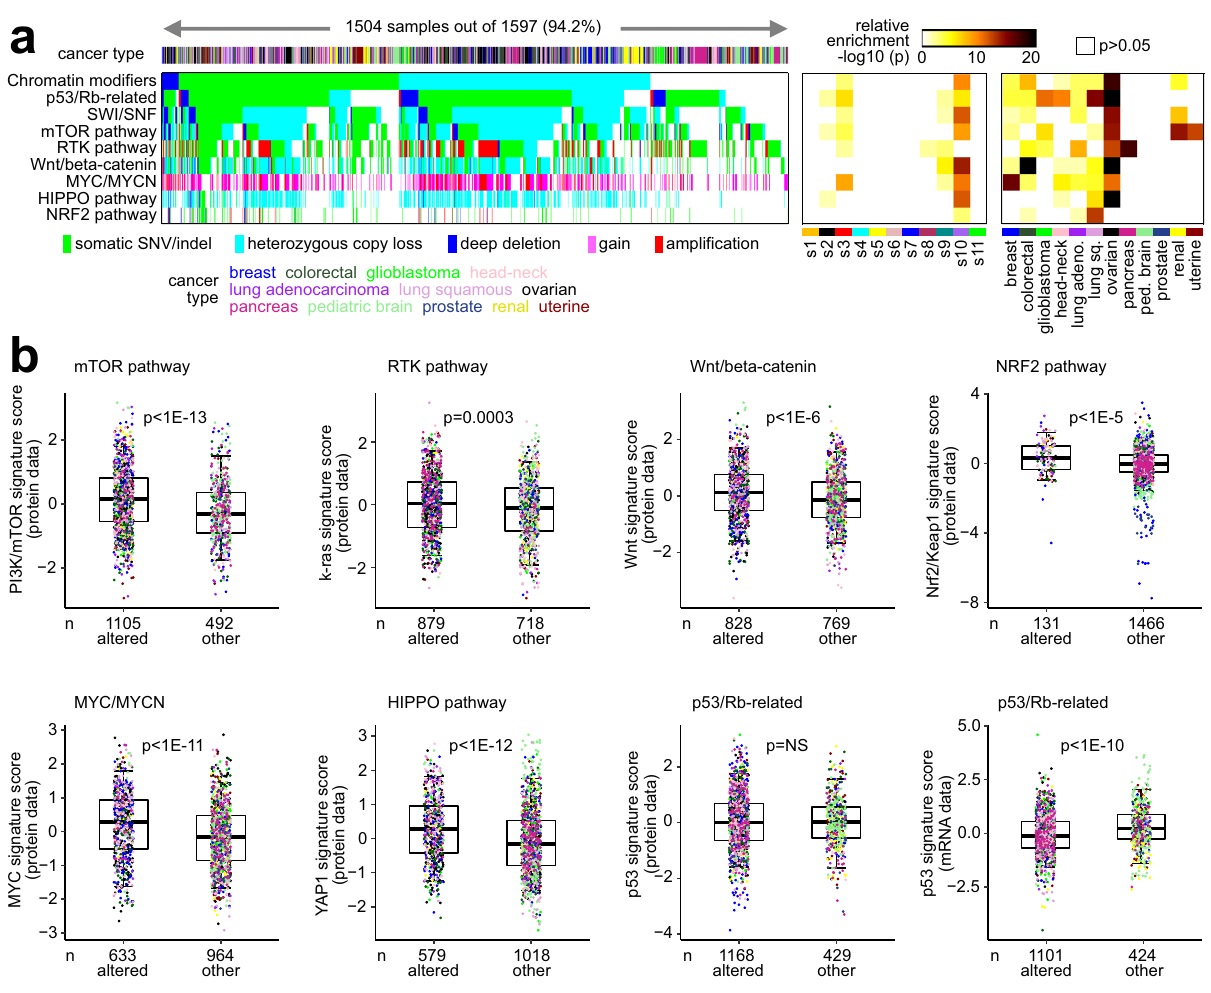
Fig. 7 Somatic mutations and associated pathways. a Pathway-centric view of somatic alterations across 1597 tumors (1504 with alteration of at least one pathway) with combined proteomic, whole-exome, and CNA data, involving key pathways and genes previously annotated across multiple cancer types based on domain knowledge (see Methods) 23,25,57,68 . Panels on the right represent the signi fi cance of enrichment (one-sided Fisher ’ s exact test) of gene alteration events for each pathway within any proteome-based molecular subtype or tissue-based cancer type versus the rest of the tumors. RTK Receptor Tyrosine Kinase. b Pathway-associated gene signatures were applied to the proteomic pro fi les, while a p53 gene signature was applied to both proteomic and transcriptomic pro fi les. Box plots compare pathway-altered versus -unaltered tumors for relative levels of the corresponding signature. p values by t -test. Box plots represent 5% (lower whisker), 25% (lower box), 50% (median), 75% (upper box), and 95% (upper whisker). n = biologically independent tumors. manner and as previously described 21,22 . First, within each proteomic pro fi le, we studies 3 – 19 (Supplementary Data 1). Most of these previous studies were led by either CPTAC or the International Cancer Proteogenome Consortium (ICPC). The normalized logged expression values to standard deviations from the median. cancer types represented in the proteomics compendium dataset were the fol- Next, we normalized expression values across samples to standard deviations lowing: Breast Invasive Carcinoma ( n = 230 tumors with proteomics data) 3,4 , from the median. Similarly, we separately normalized both total protein and phospho-protein datasets for a given cancer type and dataset. For datasets where Colorectal Adenocarcinoma ( n = 187) 5,6 , Gastric Cancer ( n = 80) 18 , Glioblastoma two different data centers generated values on the same tumors, we averaged ( n = 100) 7 , Head and Neck Squamous Cell Carcinoma ( n = 108) 8 , Hepatocellular normalized values from the respective data centers in instances of duplicate Carcinoma ( n = 165) 17 , Lung Adenocarcinoma ( n = 111) 9 , Lung Squamous Cell pro fi les for the same tumor sample. As intended, by normalizing expression Carcinoma ( n = 110) 10 , Ovarian Serous Cystadenocarcinoma ( n = 269) 11,12 , Pan- within each cancer type and within each proteomic dataset, neither tissue- creatic Ductal Adenocarcinoma ( n = 137) 13 , Pediatric Brain Tumors ( n = 219) 14 , dominant differences nor inter-laboratory batch effects would drive the Prostate Adenocarcinoma ( n = 76) 19 , Renal Cell Carcinoma ( n = 110) 15 , and downstream analysis results, including unsupervised subtype discovery. For the Uterine Corpus Endometrial Carcinoma ( n = 100) 16 . The 2002 tumors in the compendium dataset of total proteins, a total of 15,439 unique genes by Entrez compendium represented 1982 patients, with the pediatric brain tumor dataset Identi fi er were represented in at least one of the individual datasets. For the involving 219 tumors from 199 patients. The above studies analyzed the tumors compendium dataset of phospho-proteins, a total of 199,284 phospho-proteins, using global proteomic and phosphoproteomic pro fi ling by liquid involving 11,671 unique genes, were represented in at least one of the individual chromatography-tandem mass spectrometry (LC-MS/MS). We obtained processed datasets. Of these phospho-proteins, 5419 had available data for >50% of protein expression data from the CPTAC Data Portal 49 or the associated pub- samples in at least seven cancer types. lications ’ supplementary tables. Proteomic data, as provided by the CPTAC Data Portal and related publications, were processed at the gene level rather than at the protein isoform level; as a simpli fi cation, we did not consider different isoforms for the same protein in the present study. For each study, taking the expression values provided in the associated data table, we normalized proteomic data for downstream analyses in the following TCGA, we obtained TCGA data RNA-seq data from the Broad Institute ’ s Firehose NATURE COMMUNICATIONS| (2022) 13:2669